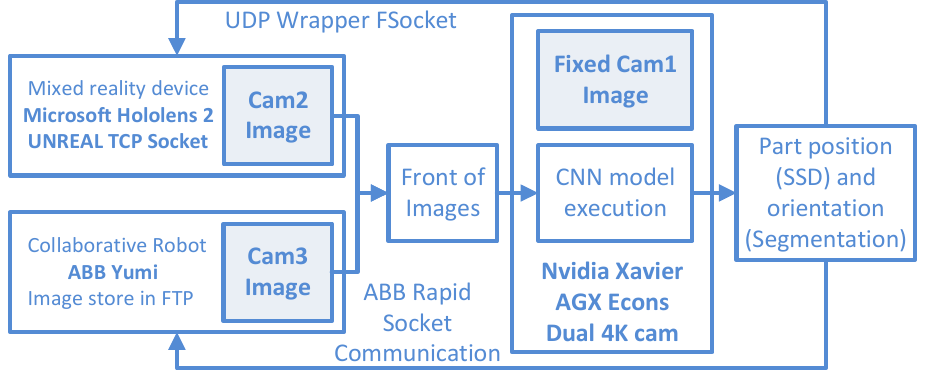
Figure 15. SMART vision system of the collaborative work cell: ( a ) CNN processing unit NVIDIA Xavier AGX; ( b ) Mixed reality device camera; ( c ) Collaborative robot ABB Yumi Vision system integrated into the right hand.